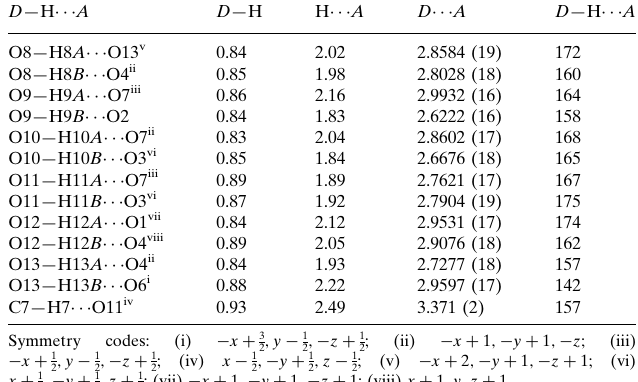
Hydrogen-bond geometry (A˚ , (cid:2)